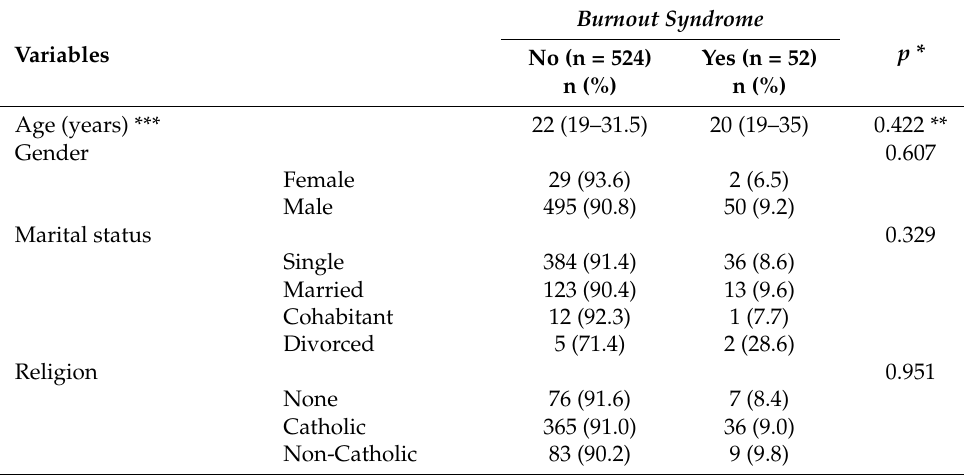
Table 2. Characteristics associated with burnout syndrome in the